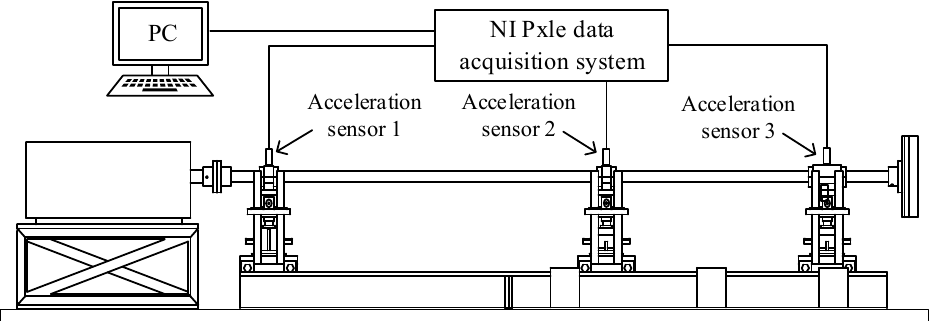
Figure 2. Schematic of Experimental